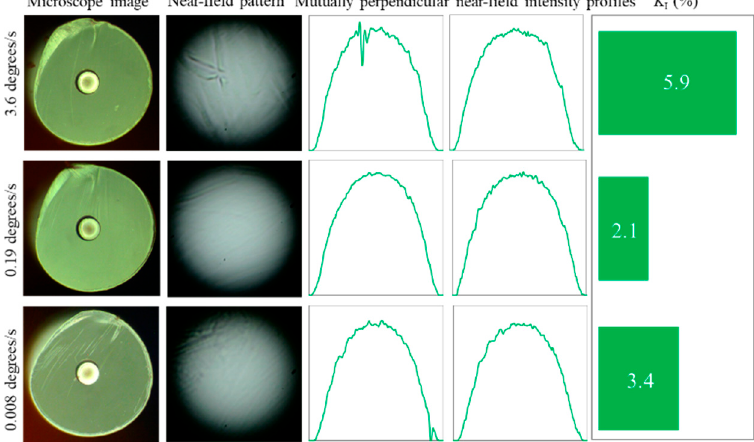
Figure 7. Typical results of cleaves performed at different speeds with the Feather razor blade (RB). The cleaving time was 2 s, 28 s and 14 min (from top to bottom).